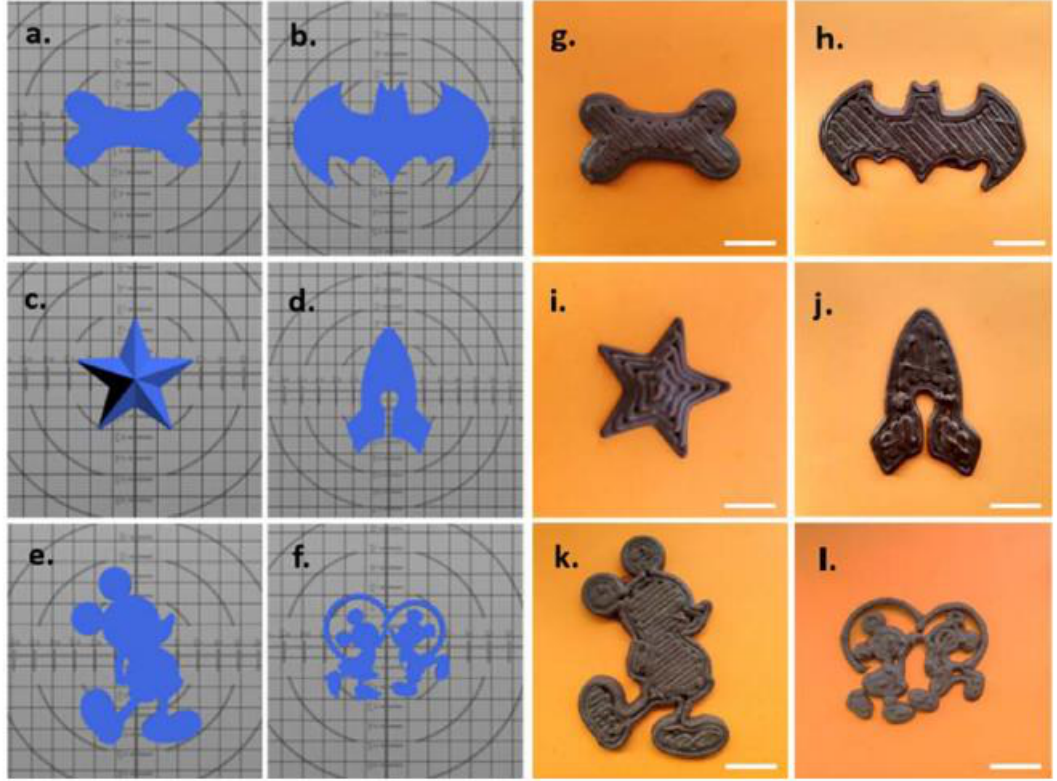
Figure 5. Schematic representation of the ( a – f ). Stl files and the ( g – l ). 3D printed chocolate-based dosage forms. Scale bar: 20 mm (from Karavasilli et al. [38], with permission).